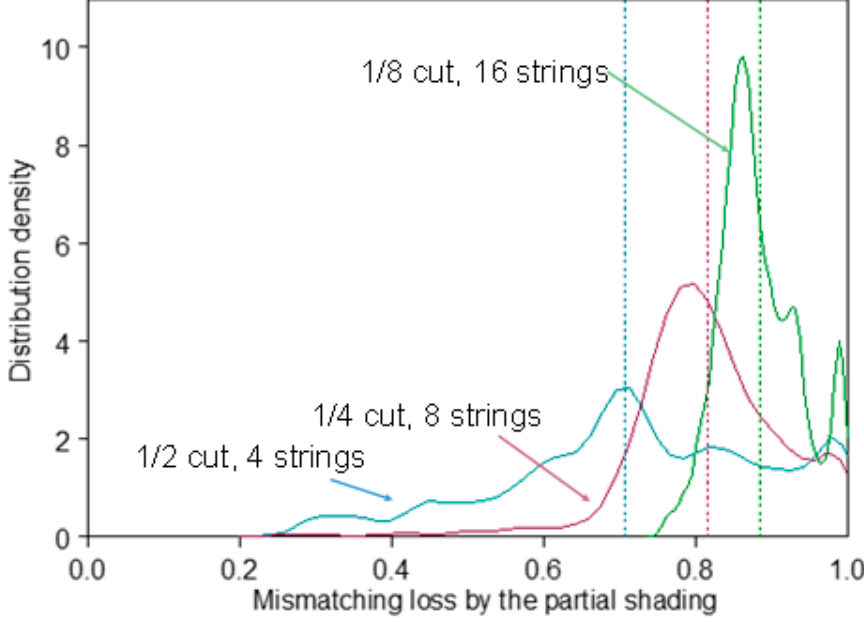
Figure 20. Distribution of the normalized e ffi ciency of some design of the car roof PV a ff ected by synthesized partial shading given by the Monte Carlo simulation. Note 1 / 6 or more cut is recommended for suppressing partial-shading loss to <